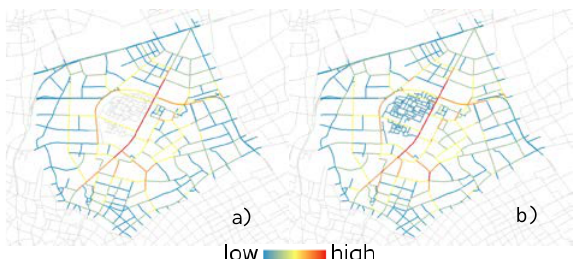
Figure 9. Betweenness centrality values calculated by simulation, a) when interior roads of Danwei and Xiaoqu are not integrated into the road network, b) when interior roads of Danwei and Xiaoqu are integrated into the road network.